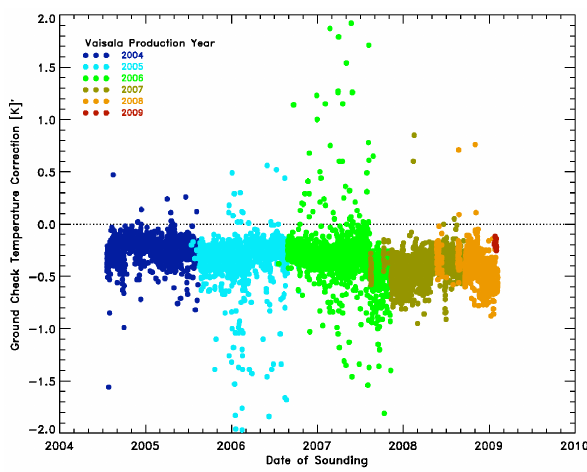
Fig. 3. Correction of Vaisala RS92 radiosondes determined form the routine ground check.